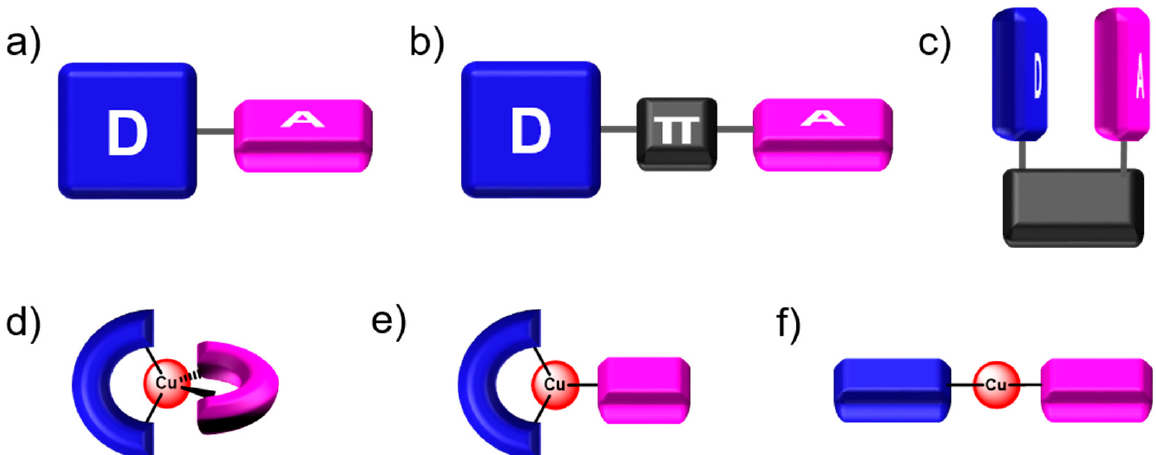
Figure 1. Molecule designs of organic and Cu(I) thermally-activated delayed fluorescence (TADF) emitters: ( a ) highly twisted D-A structure with through-bond charge transfer (TBCT) excited state; ( b ) separated D and A segments by a π spacer; ( c ) intramolecular D-A pair with through-space charge transfer (TSCT) excited state; ( d ) tetrahedral, ( e ) trigonal, and ( f ) linear coordination geometries for Cu(I) complexes with predominant ligand-to-ligand charge transfer (LLCT) excited state.